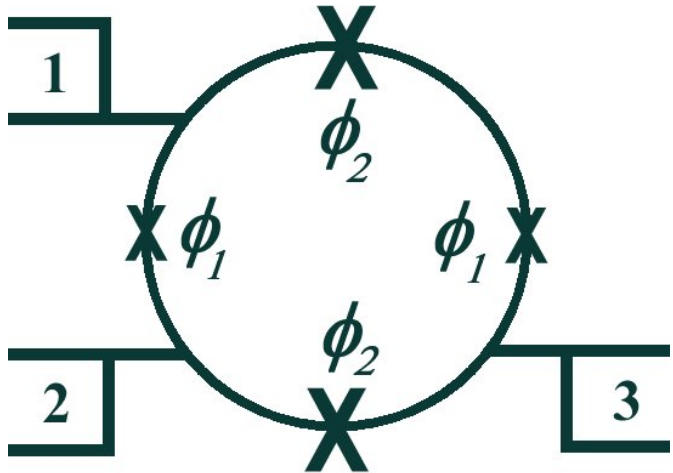
Figure 1. Schematic diagram of a 4 nJJ nanoSQUID with 3 current leads. Josephson junctions with larger critical currents I c2 and smaller phase drops φ 2 < π /2 are shown by larger crosses.